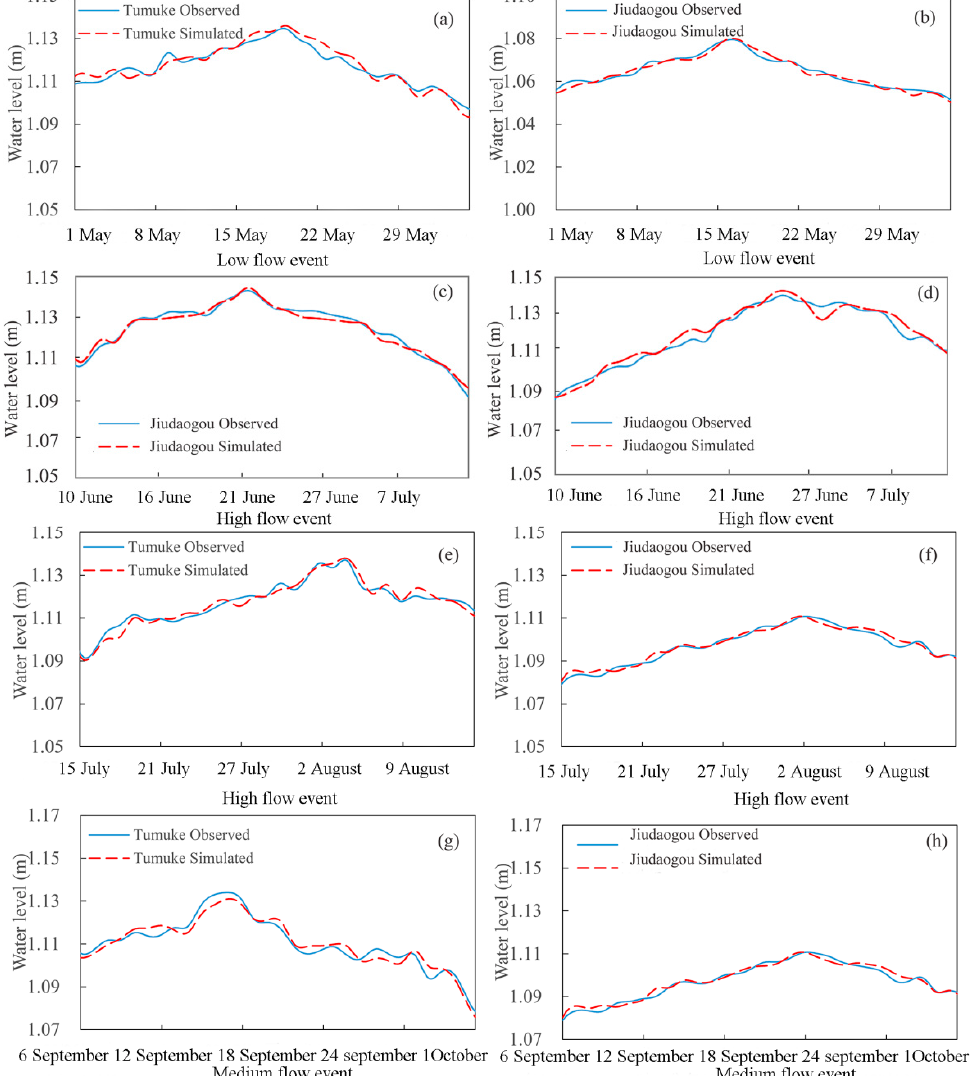
Figure 4. Simulated and observed water levels at Jiudaogou and Tumuke for the calibration and evaluation periods. Water levels during May 2014 in the calibration period ( a ) and ( b ), water levels from June to July 2014 in the calibration period ( c ) and ( d ), water levels from July to August 2014 in the evaluation period ( e ) and ( f ), and water levels in September 2014 in the evaluation period ( g ) and ( h ).